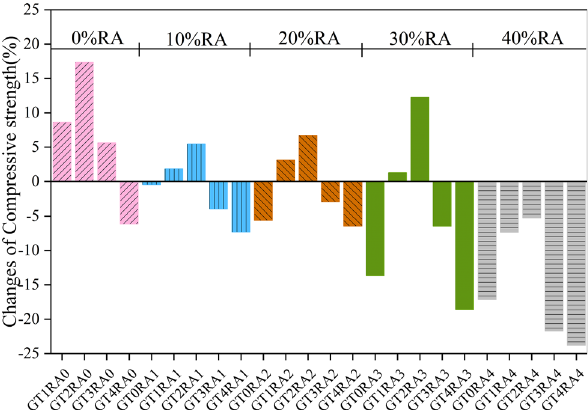
Figure 9: Changes in compressive strength of GTRAC.